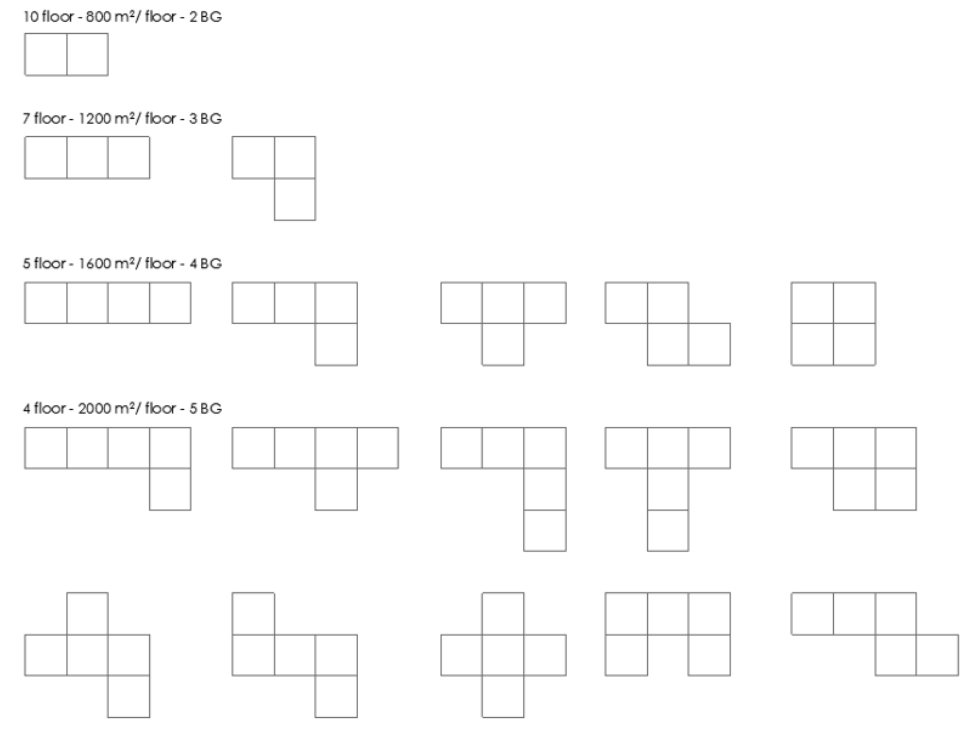
Figure 2. Examined building forms using 2–5 BGs.